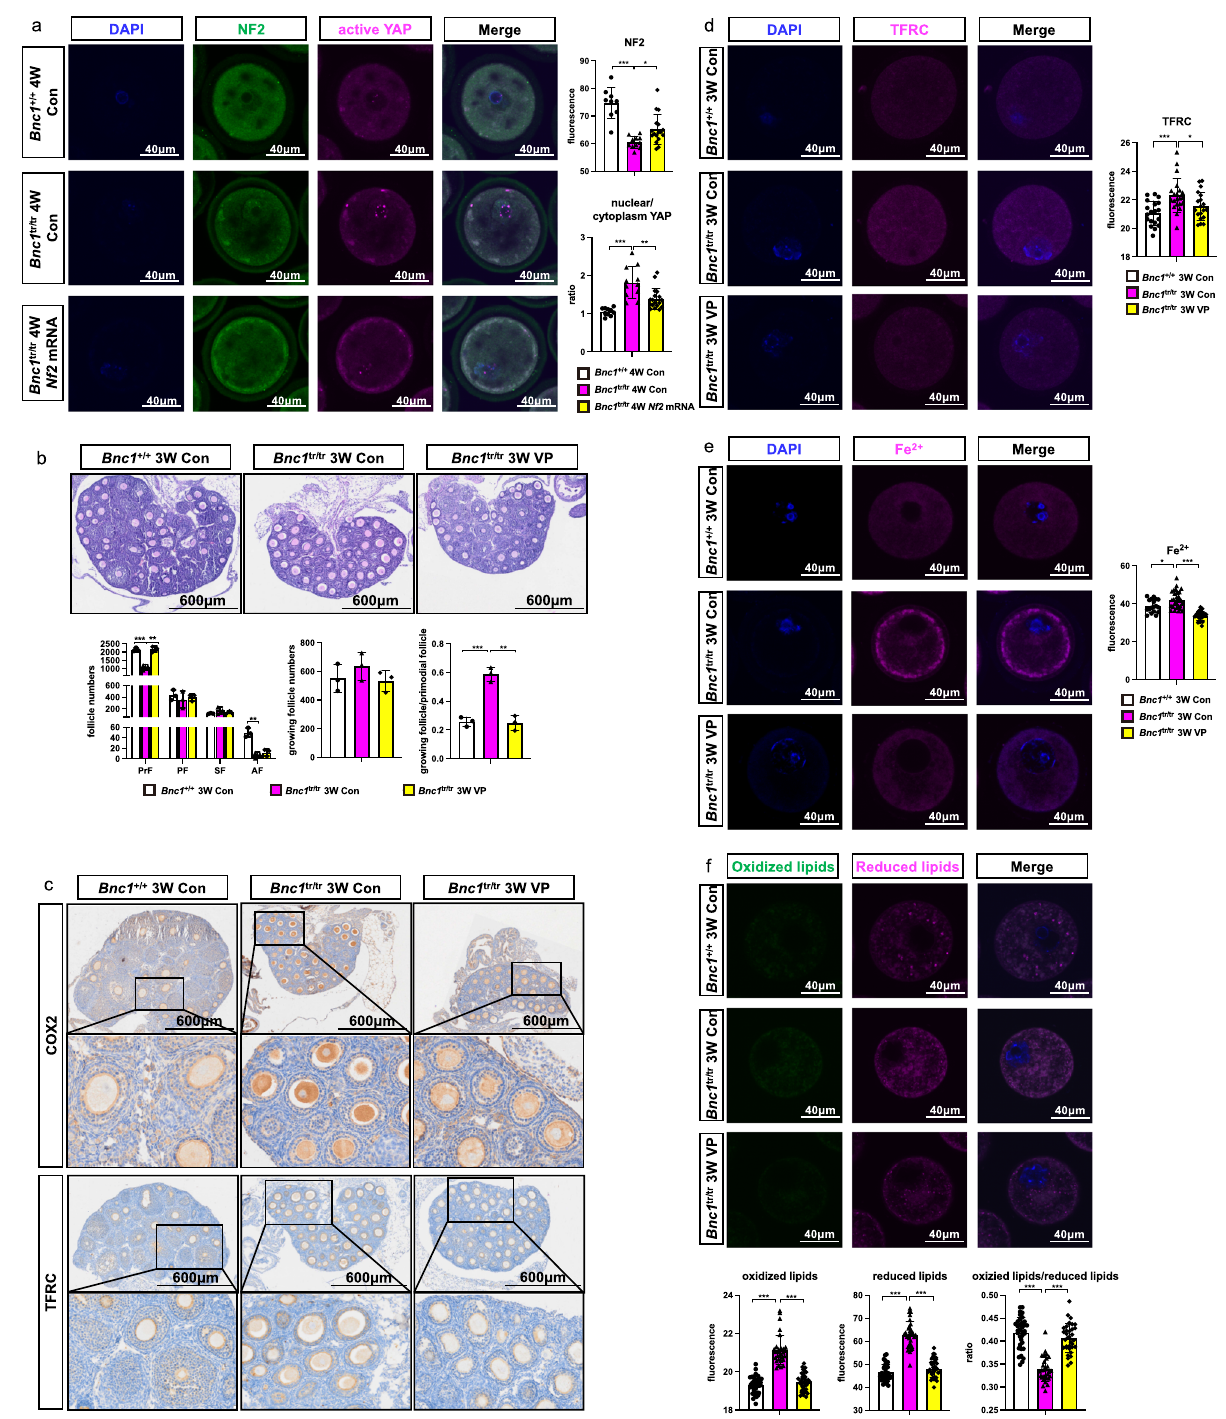
Fig. 7 | Targeting NF2-Hippo/YAP signaling pathway rescues Bnc1 mutation induced ferroptosis. a Immuno fl uorescence of NF2 and active YAP in GV oocytes ( p value<0.0001 for NF2 of Bnc1 tr/tr Con, p value=0.0120 for NF2 of Bnc1 tr/tr Nf2 mRNA, p value<0.0001 for nuclear/cytoplasmic YAP of Bnc1 tr/tr Con, p value= 0.0023 for nuclear/cytoplasmic YAP of Bnc1 tr/tr Nf2 mRNA, 3 independent experi- mentswithtotaloocytenumbers>30oocytes). b HEstainingandPrFs,PFs,SFsand AFs of Bnc1 +/+ Con ( n =3), Bnc1 tr/tr Con ( n =3, p value=0.0008 for PrFs, p value= 0.4975 for PFs, p value=0.1942 for SFs, p value=0.0019 for AFs, p value=0.3379 forgrowingfolliclesand p value=0.0007forgrowingfollicles/PrFs)and Bnc1 tr/tr VP ( n =3, p value=0.0013 for PrFs, p value=0.7104 for PFs, p value=0.3955 for SFs, p value=0.3796 for AFs, p value=0.2134forgrowingfolliclesand p value=0.0012 for growing follicles/PrFs) mice at 3 weeks old. Scale bar=600 μ m. c IHC of COX2